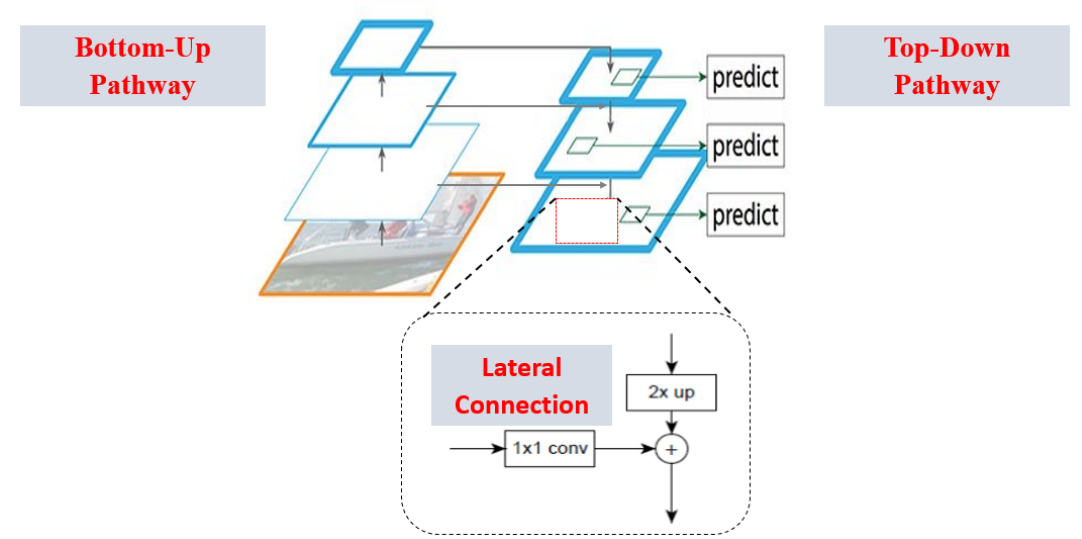
Figure 8. Feature pyramid network architecture